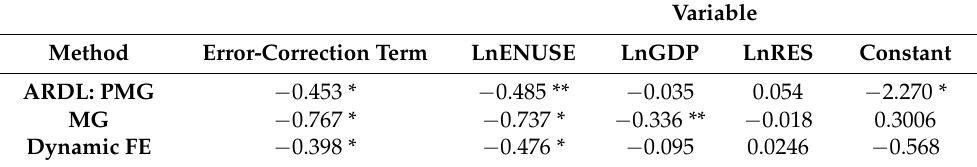
Table 7. Short-run estimations.